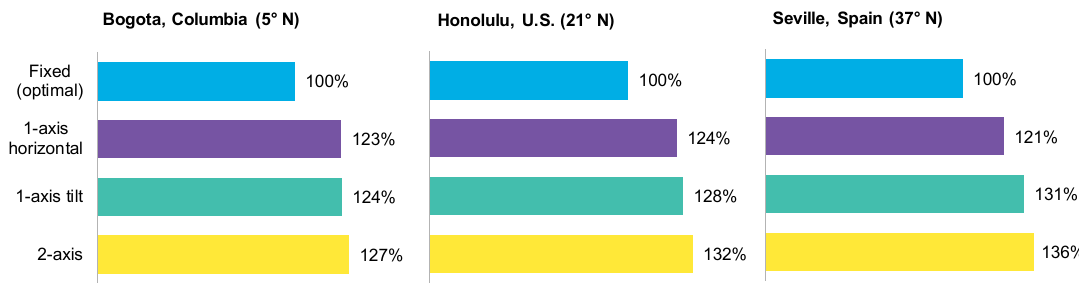
Figure 17. 2018 annual irradiation collected by a PV module in different mounting scenarios.